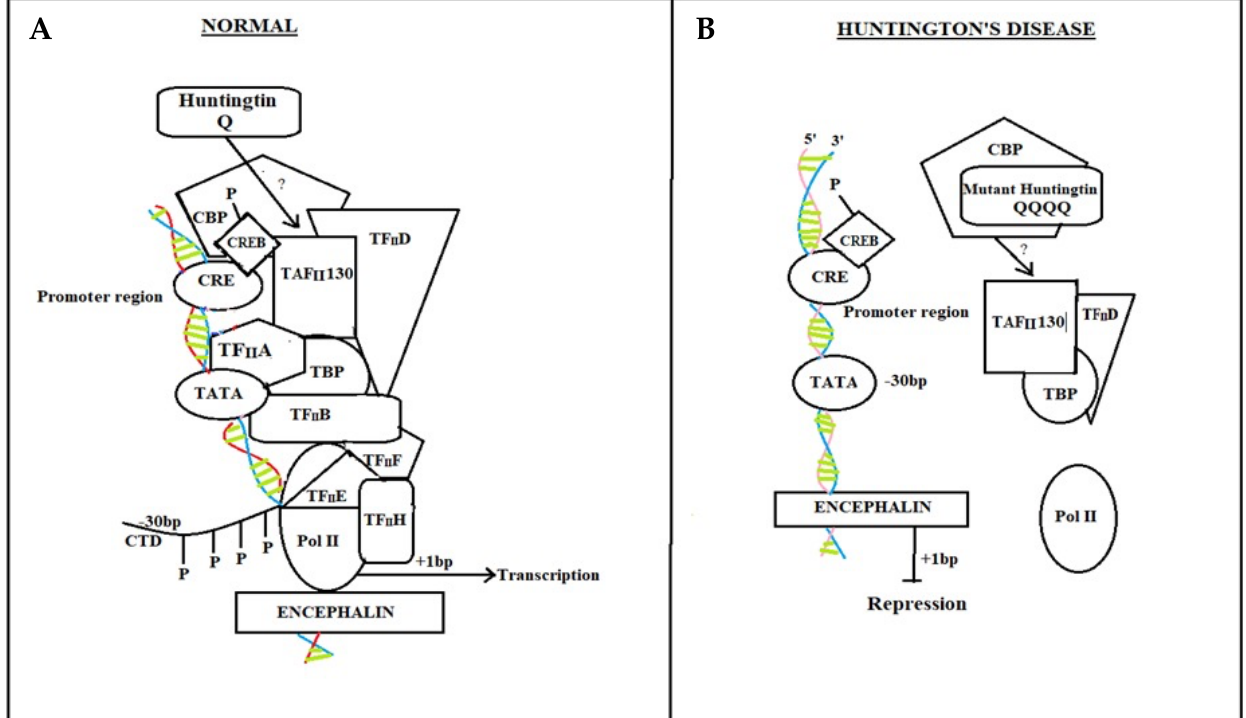
Figure 1. CREB protein pathway in Normal individual and HD diseased patient. In normal individuals, CREB binding with CRE enables normal neuronal responses by activating a cascade of transcriptional factors ( A ) while in Huntington’s disease patients, due to mutant htt gene, CRE transcriptional cascade breaks, and there is no attachment of CBP and TAFII 130 with CRE. Pol II dispositioned ( B ).